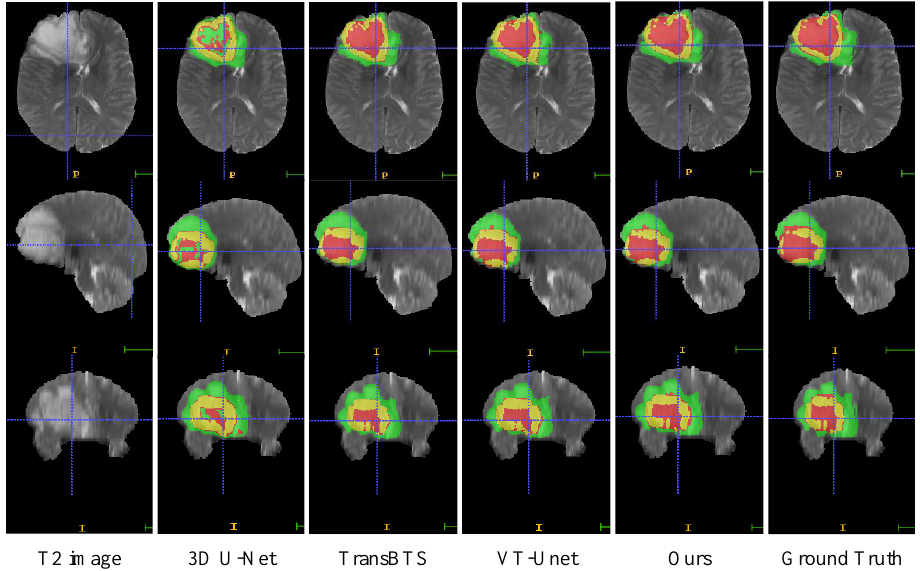
Figure 6. Visual comparison of MRI image segmentation results.